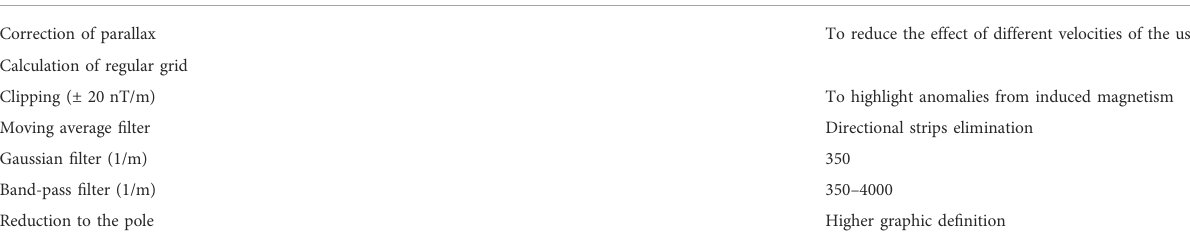
TABLE 1 Processing chain applied to the magnetic